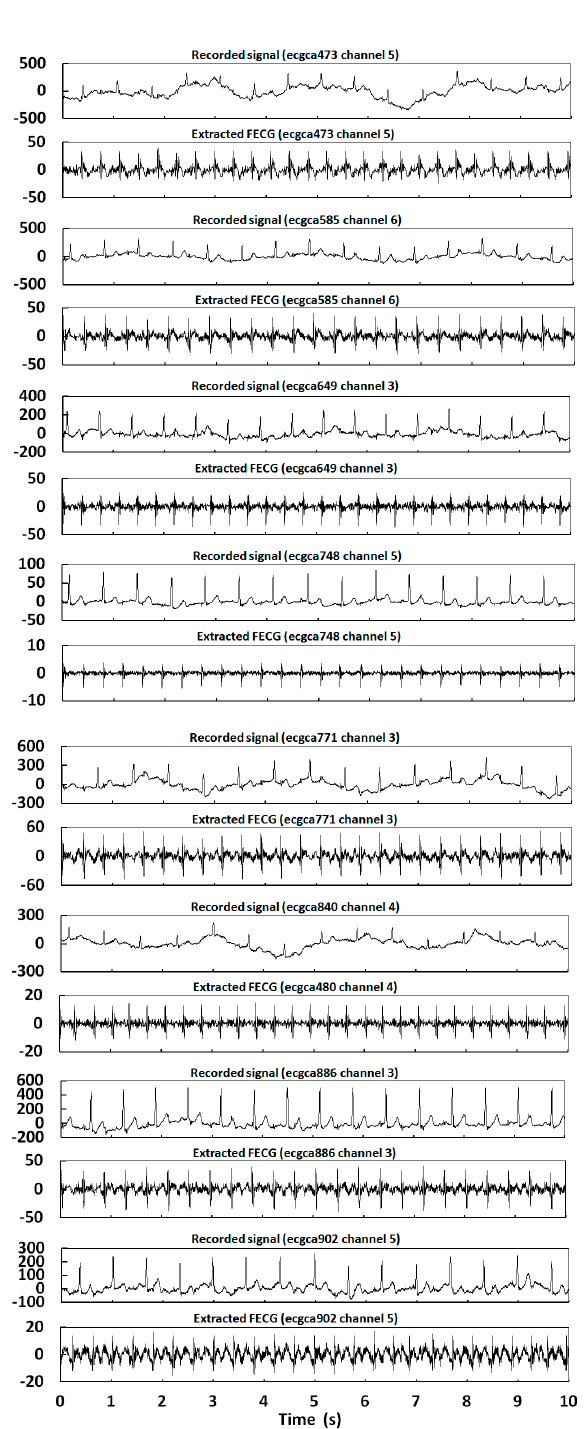
Figure 17. Extraction results for eight records in the NIFECGDB database.